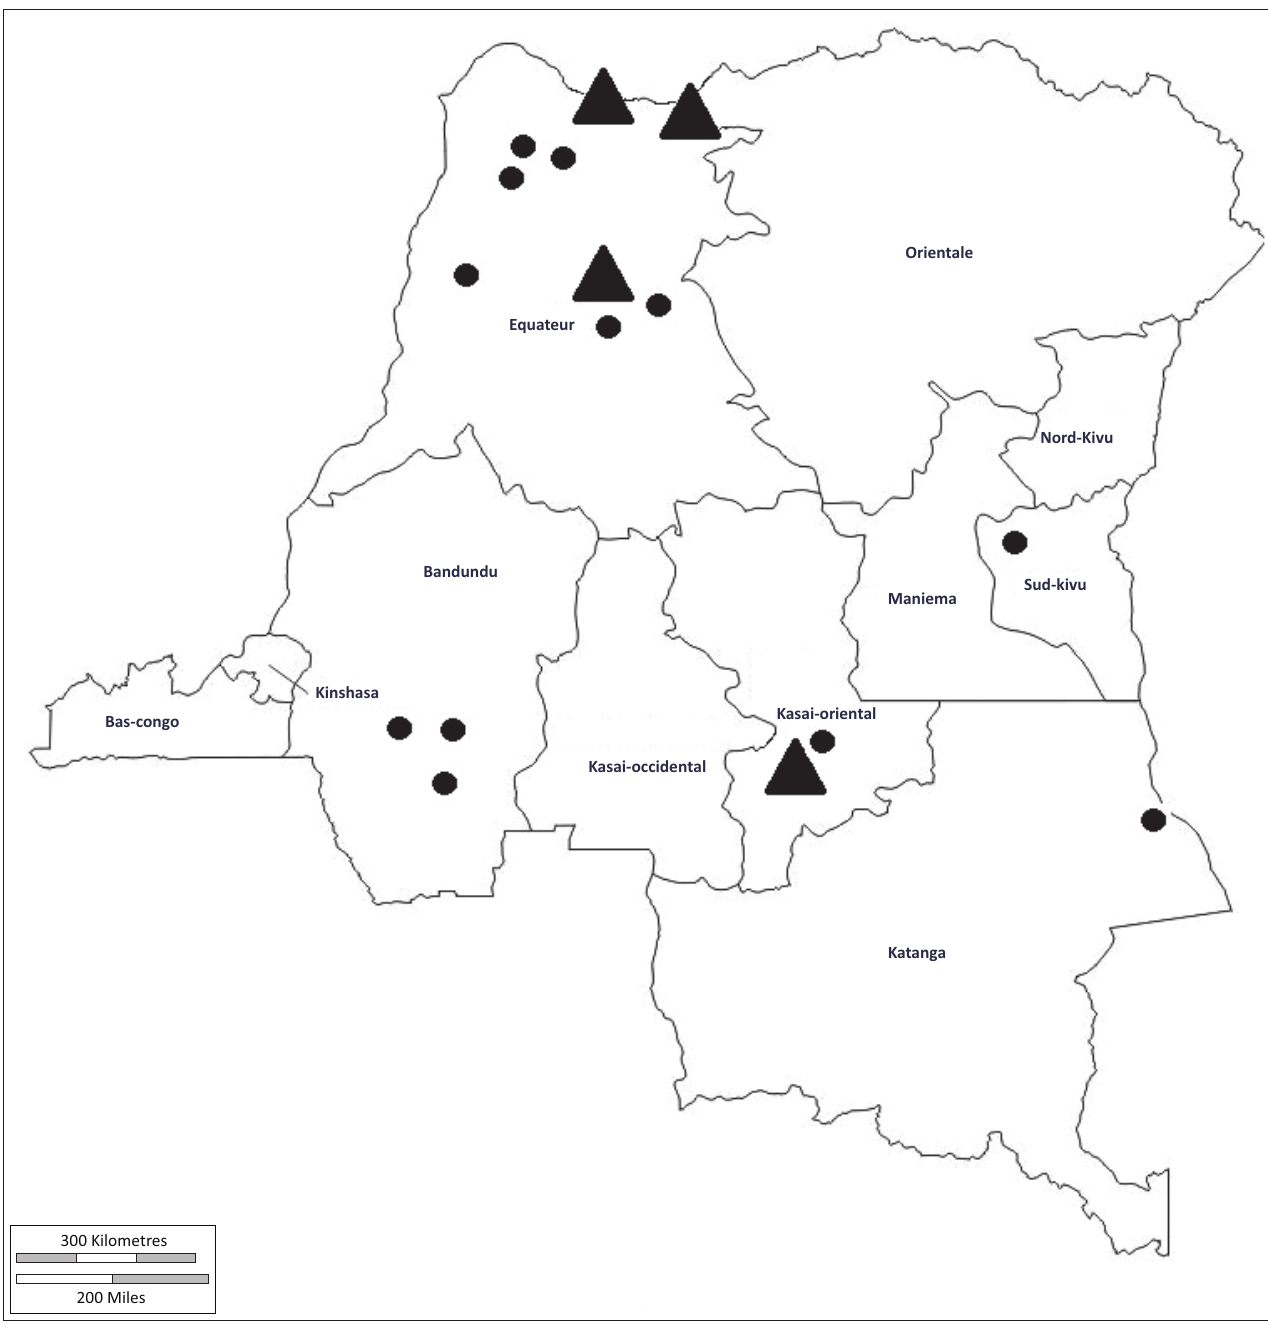
FIGURE 1: Map of Democratic Republic of the Congo showing locations of sample collection (adapted with permission from www.d-maps.com). Territories with seroprevalences > 10 % are indicated with black